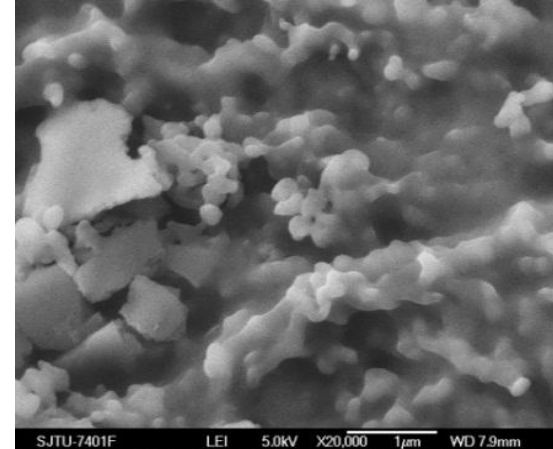
A 12 MPa, 40 °C, 1.0 mg/mL, 1.0 mL/min B 12 MPa, 45 °C, 1.0 mg/mL, 1.0